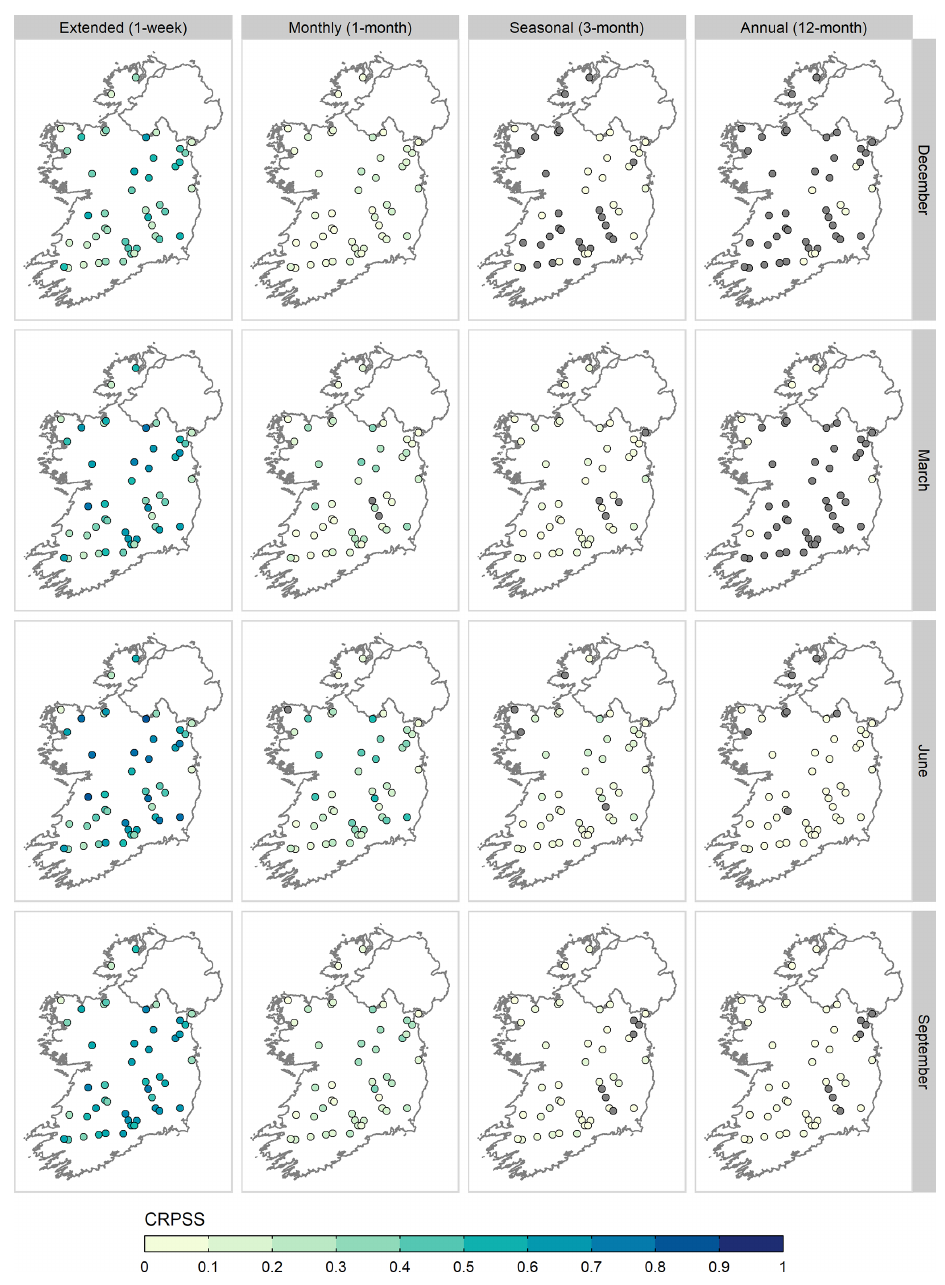
Figure 6. ESP skill for individual forecasts made at the 46 catchments for four sample lead times (columns) and 4 initialisation months (rows). Catchments with negative skill (CRPSS < 0) are greyed